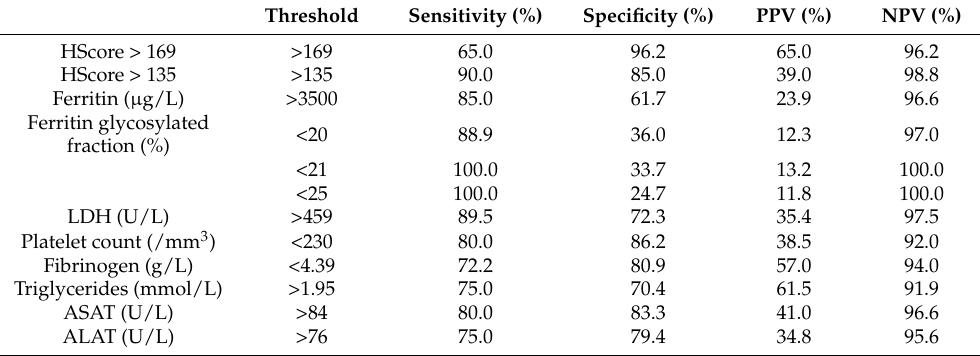
Table 4. Diagnostic values of laboratory characteristics relevant to SD-associated MAS.